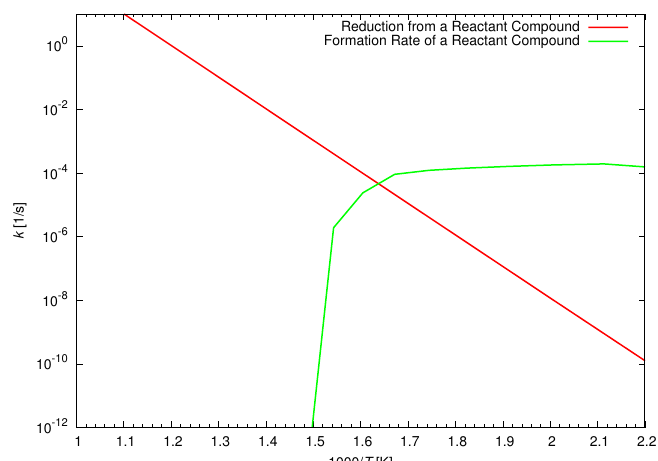
Figure 9. Rate constant for the acid catalyzed reduction of a reactant compound as well as the formation rate of a reactant compound in hot water. A hydronium approached a methanol, frequently colliding with a number of water molecules to form a reactant compound. We estimated the formation rate by representing it as a diffusion